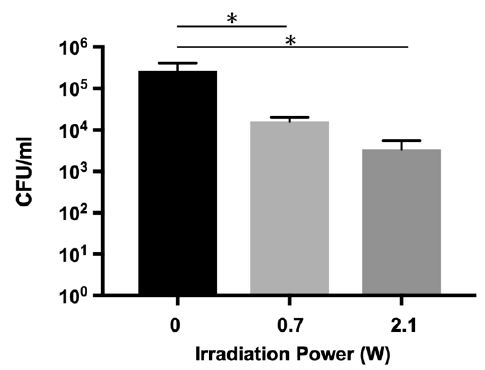
Figure 3. Bactericidal effect on E. faecalis biofilm in an infected root canal model. Lasers with dif- ferent powers (0.7 W and 2.1 W (0.49 and 1.46 W/cm 2 )) were applied for 5 min with air-cooling. A marked bactericidal effect was observed at 2.1 W irradiation. Data are presented as the mean ± standard deviation. Asterisks (*) denote p < 0.05 ( n = 3).